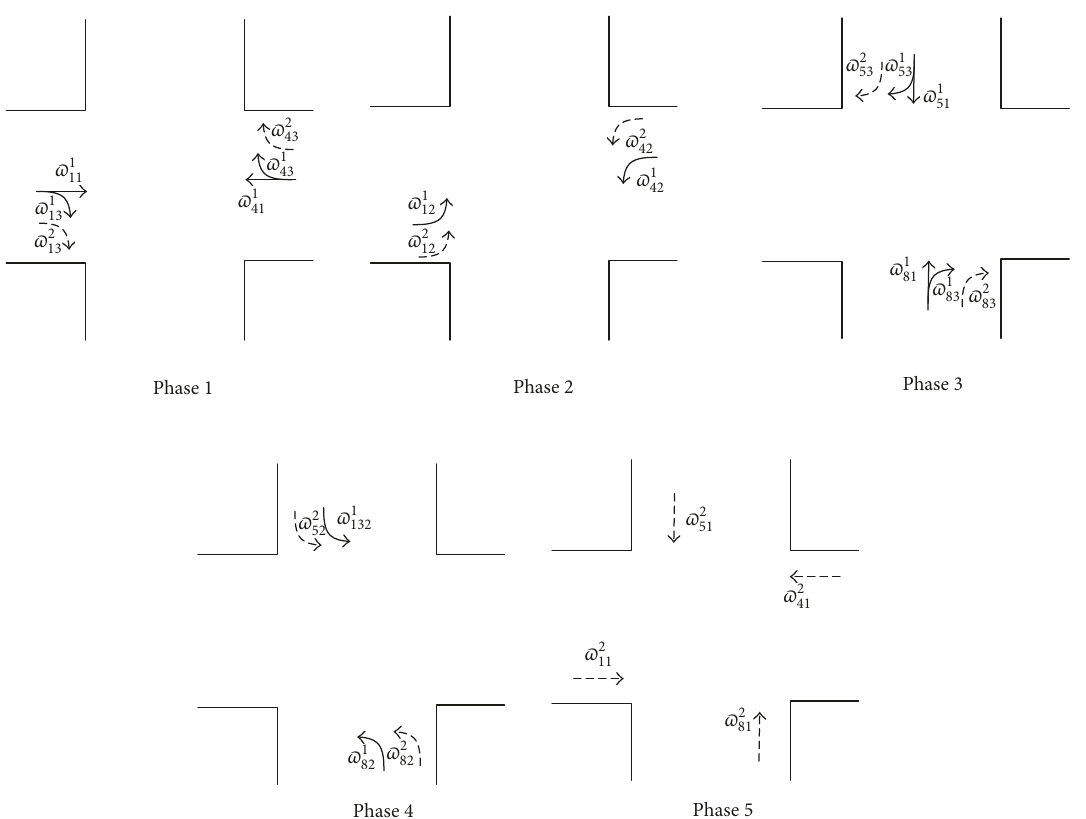
Figure 6: Illustration of control strategy 2 in intersection